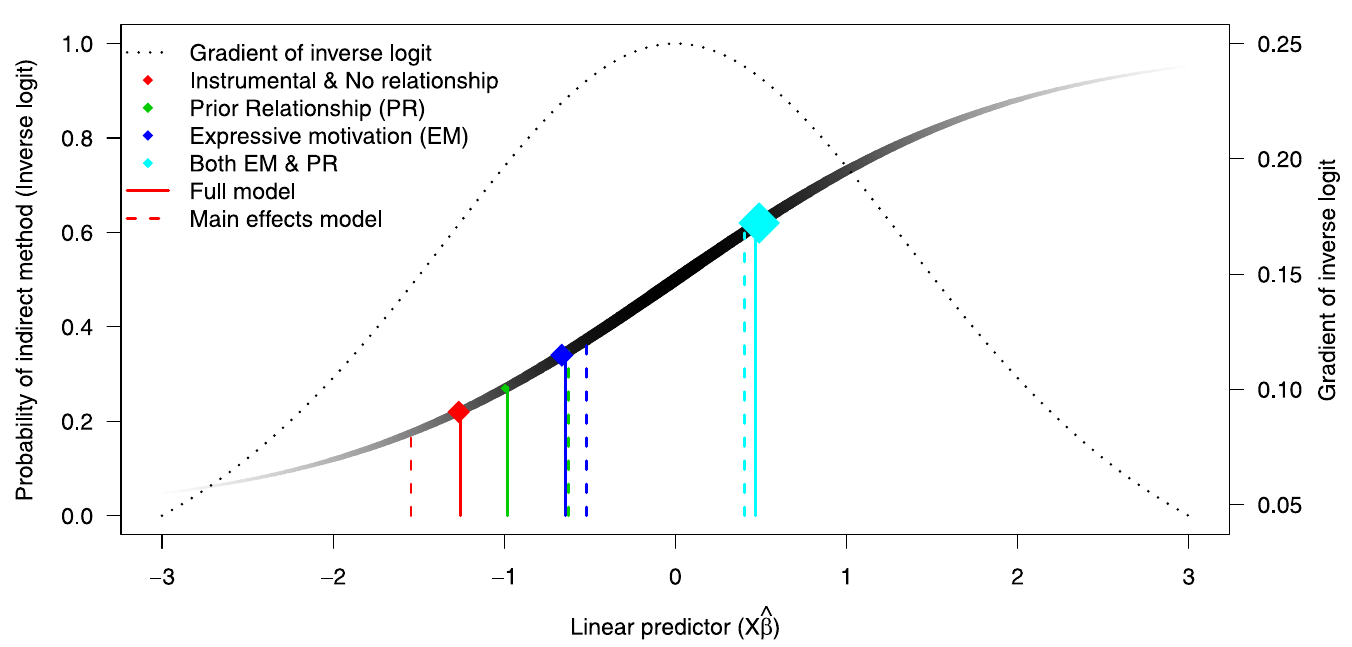
Fig 2. Change in deviance test applied to pedagogical example. The gradated grey line represents the back- transformation of the logit function (inverse logit). The grey levels in this line indicate the gradient of the function, with darker areas having the steepest slopes. The gradient is also represented by the black dashed line and the right axis. The coloured points indicate various subgroups and the size of these points represents their sample size. Solid coloured lines represent the linear predictors obtained from the full model including an interaction term. The coloured dashed lines represent linear predictors from the main effects model.